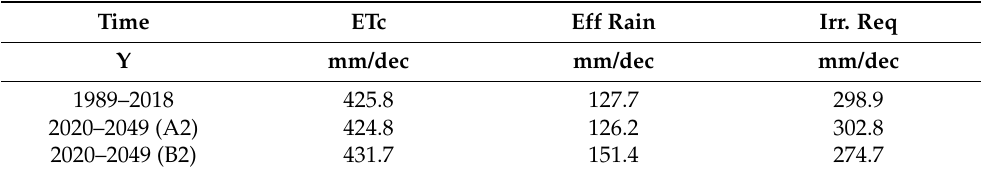
Table 8. Effective precipitation and irrigation water demand during the winter wheat growth period for the future climate model of the piedmont plain